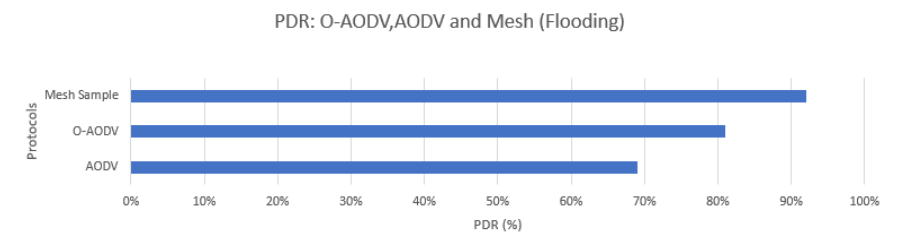
Figure 26. PDR: O-AODV, AODV, and mesh (flooding)